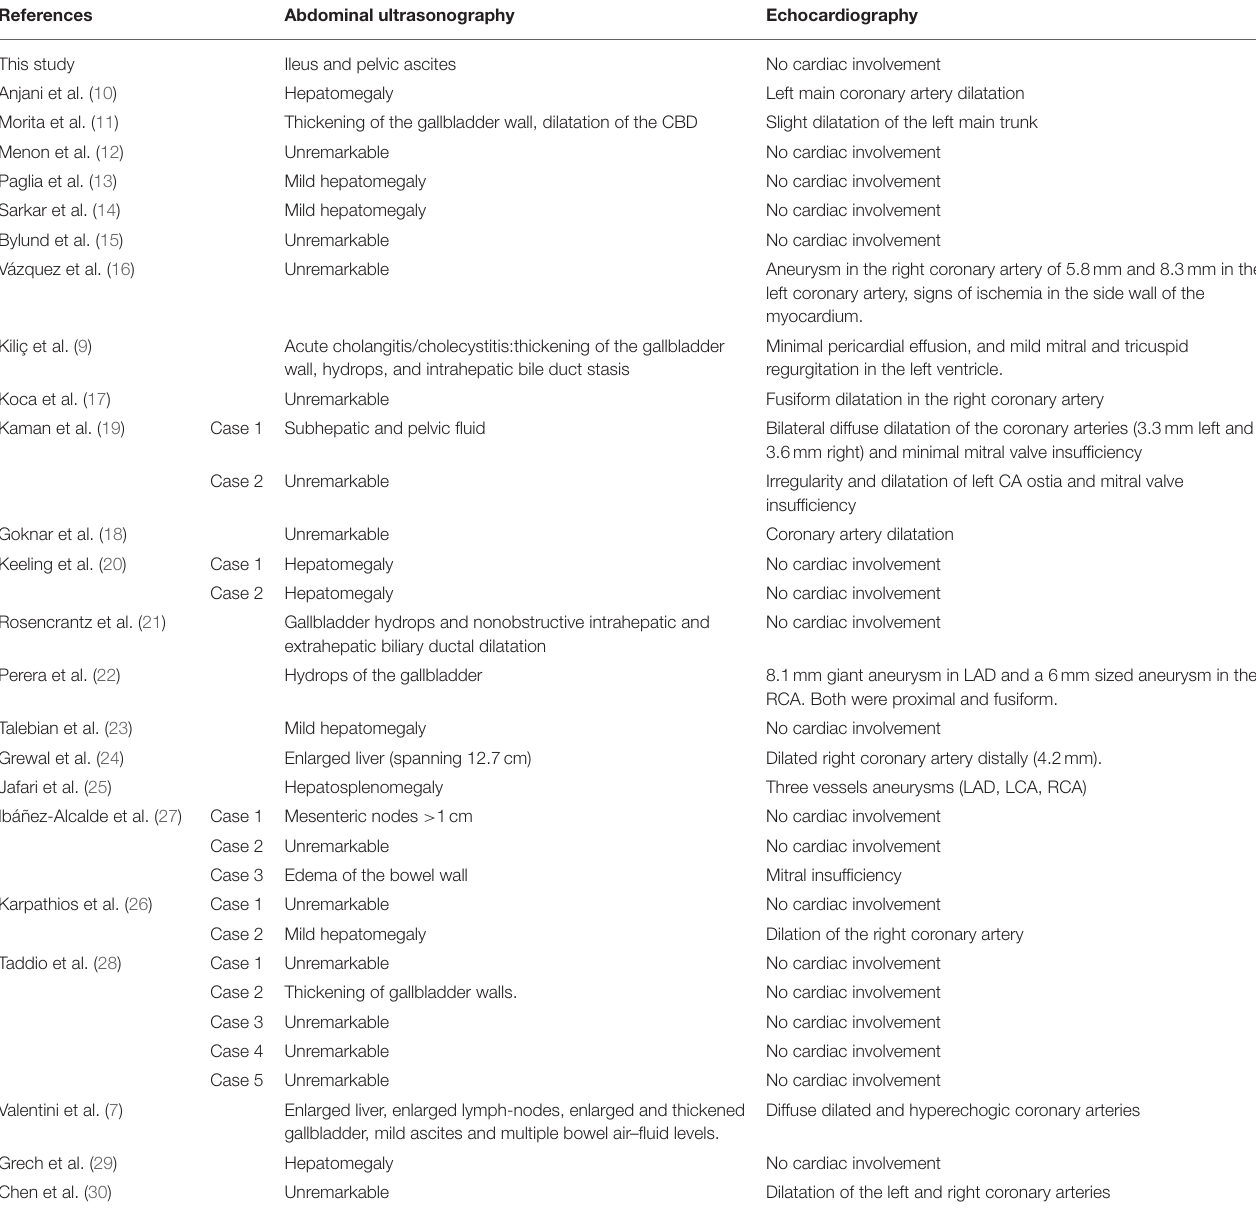
TABLE 4 | Imaging findings for 33 patients with KD and hepatobiliary